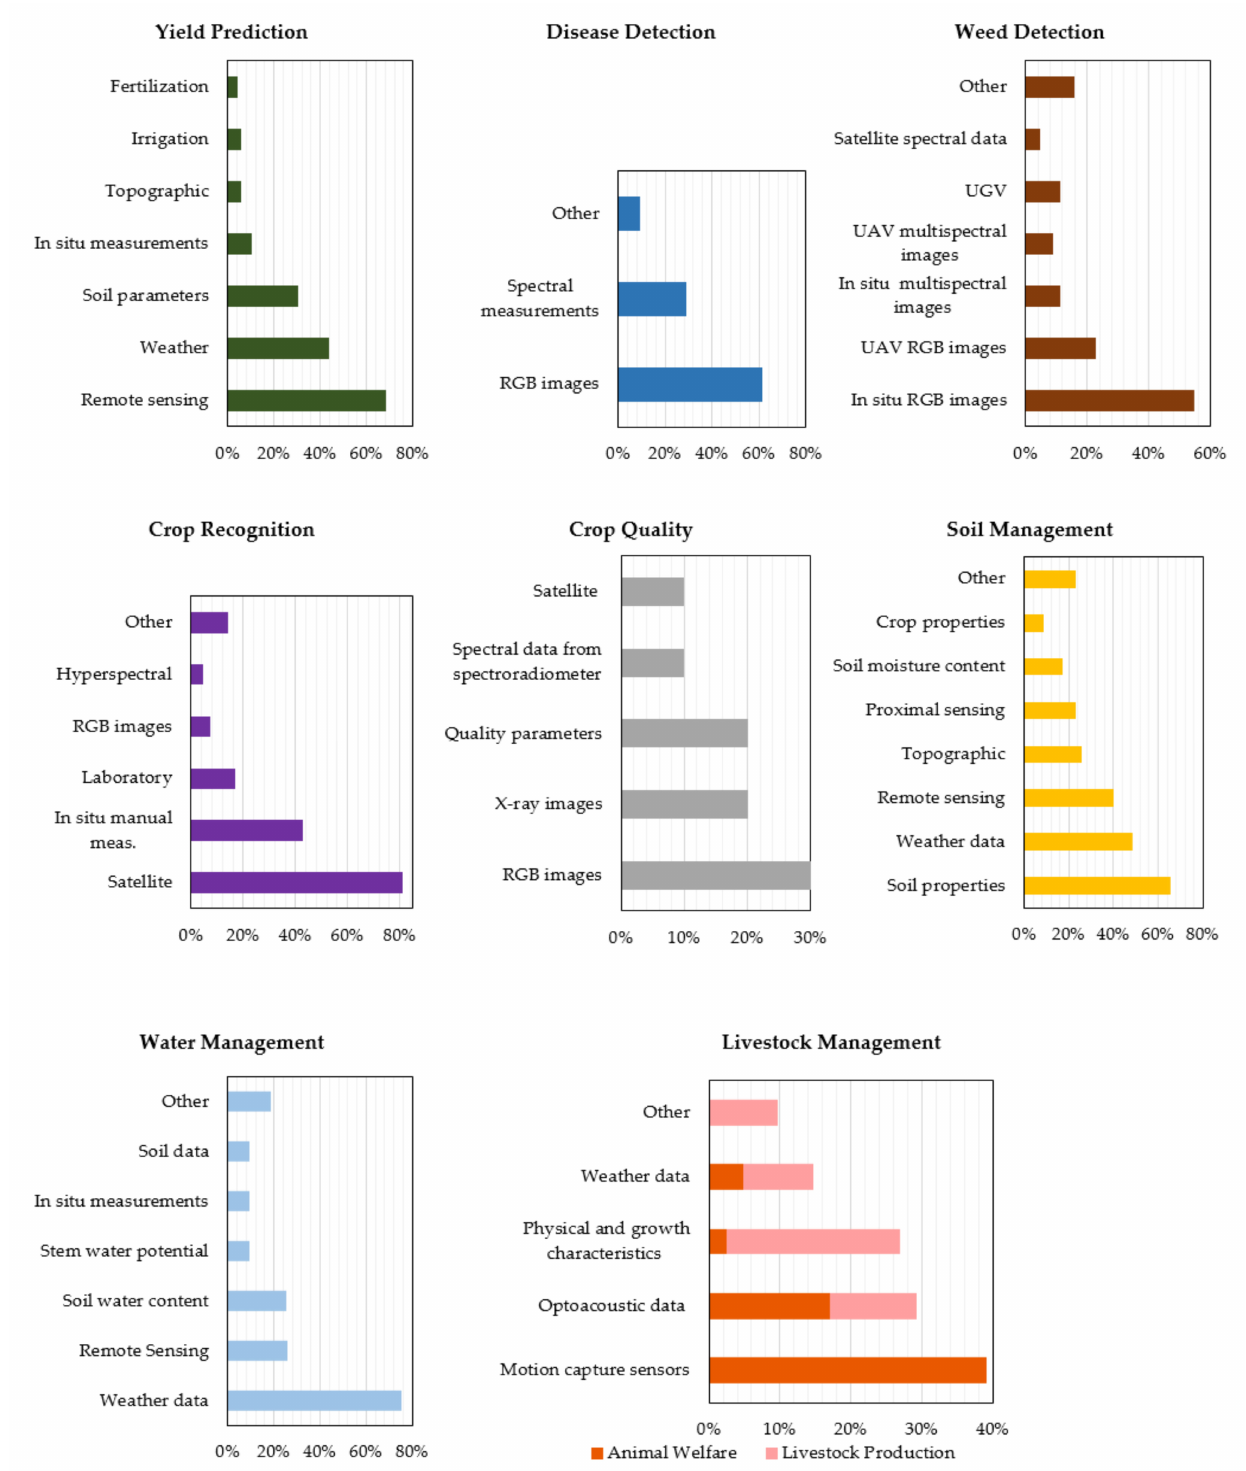
Figure 11. Distribution of the most usual features implemented as input data in the machine learning algorithms for each